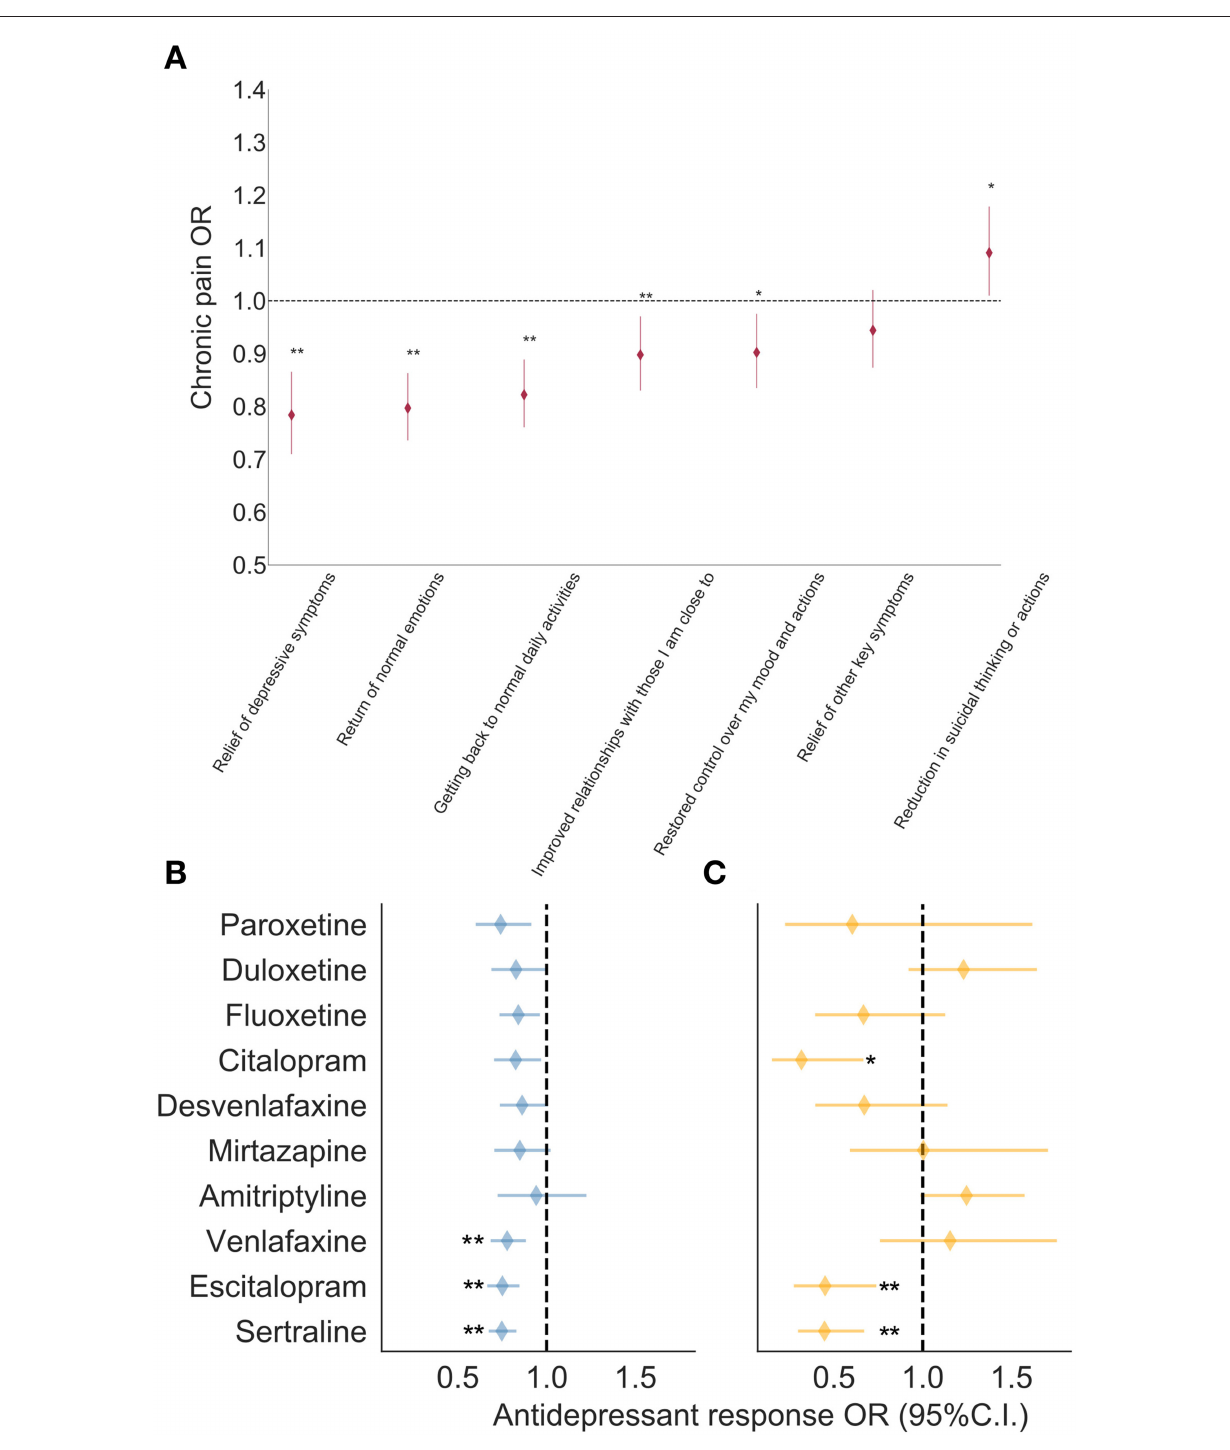
Frontiers in Psychiatry |